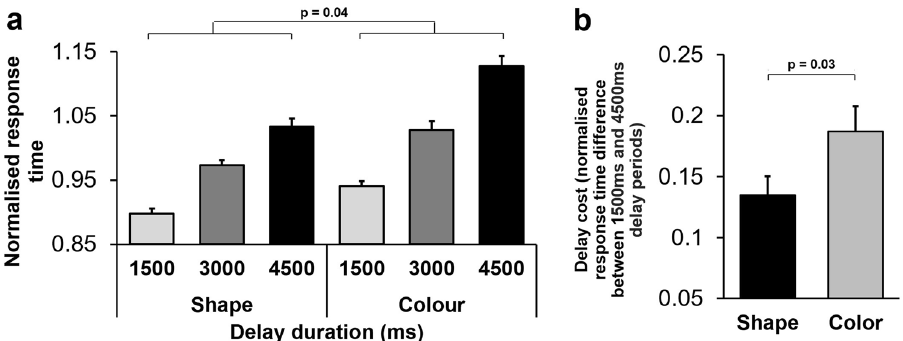
Figure 4. Delay duration and visual dimensions interactively modulated monkeys’ response. time. ( a ) Mean normalised response time is shown for each delay duration in both matching dimensions. The increase in response time due to a longer delay duration was dependent on the matching dimension. ( b ) The magnitude of delay cost (normalised response time difference between the 1500 ms and 4500 ms delay period) is shown in both matching dimensions. The delay cost was higher in the colour dimension than in the preferred shape